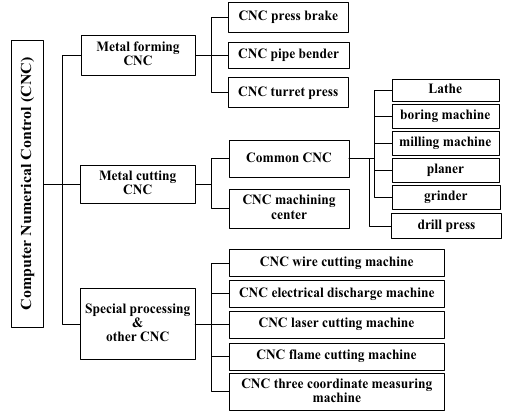
Fig.2. An example of application taxonomy: an application taxonomy of the specific field of computer numerical control (CNC).